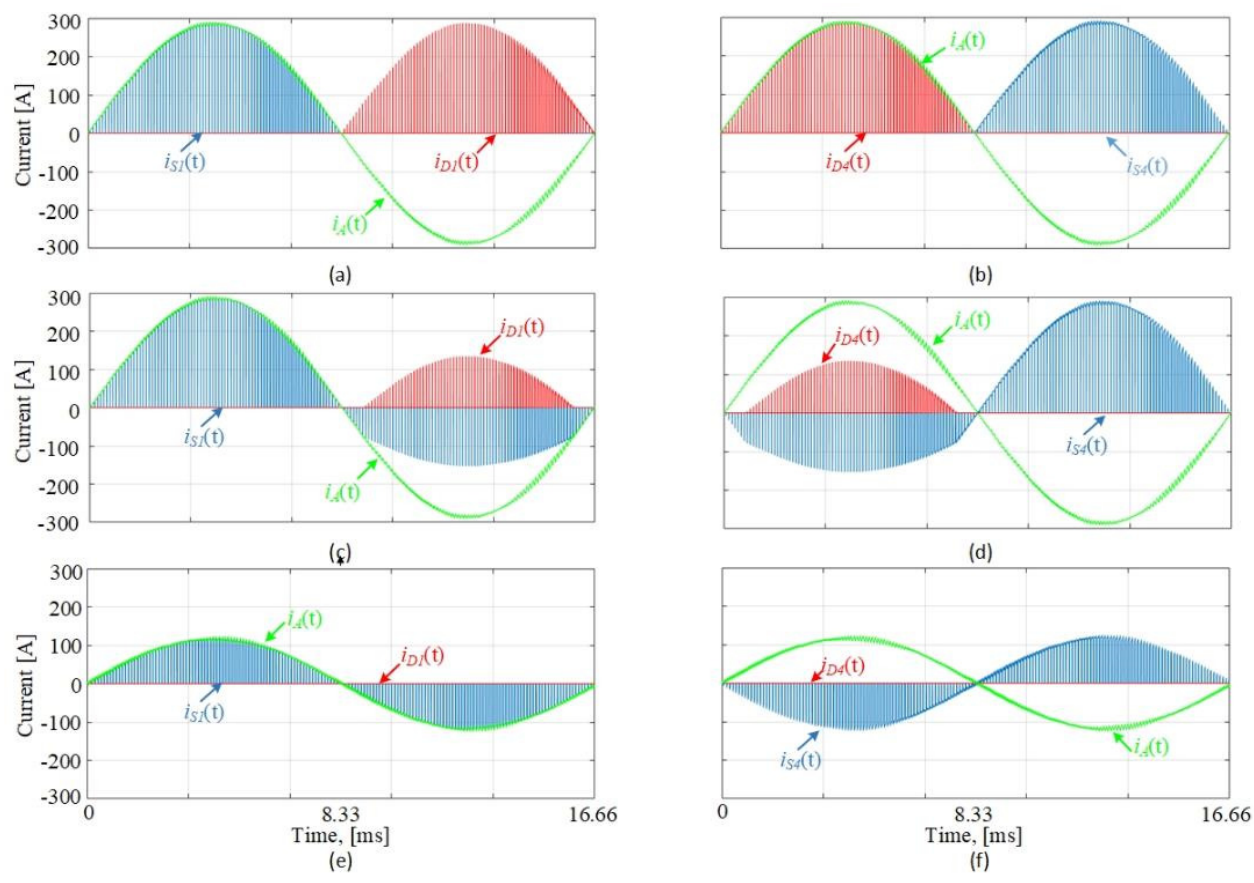
Figure 4. Current waveforms of S1, D1, S4, and D4 in Figure 3a, obtained by MATLAB/Simulink when the traction inverter is supplied with 750 V DC and applies 480 V l-to-l at 60 Hz to the stator. ( a , b ) Si-IGBT-based converter supplies 173 kVA at 0.81 pf; ( c , d ) SiC power MOSFET-based converter supplies 173 kVA at 0.81 pf, and ( e , f ) SiC power MOSFET-based converter supplies 75 kVA at 0.29 pf.